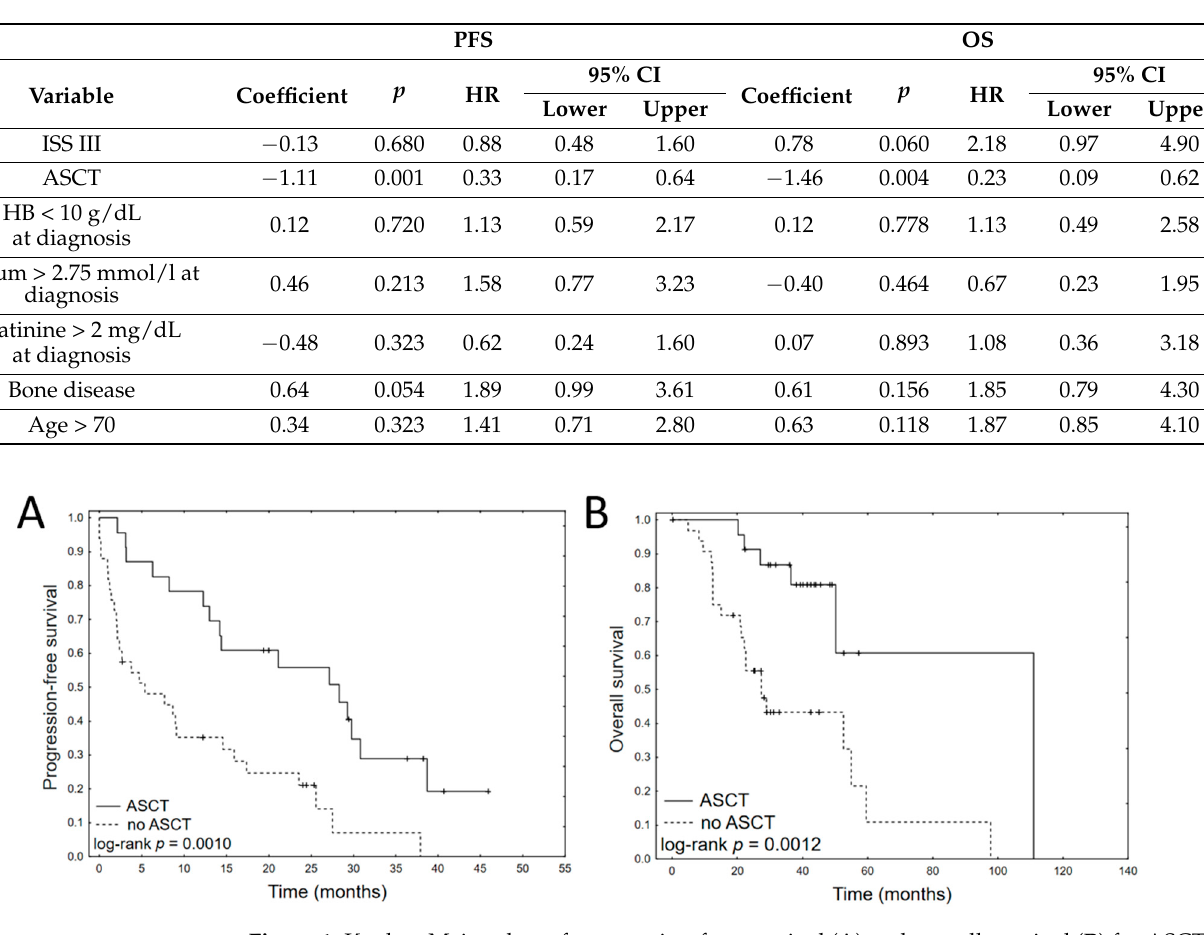
Table 2. Univariate Cox regression analyses of basic clinical variables for progression-free survival and overall survival.